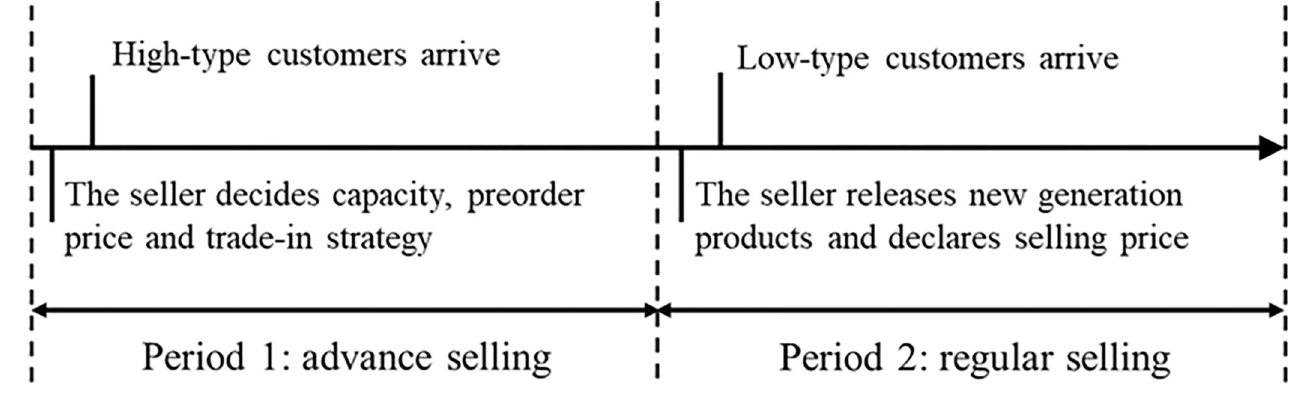
Fig 1. The sequence of